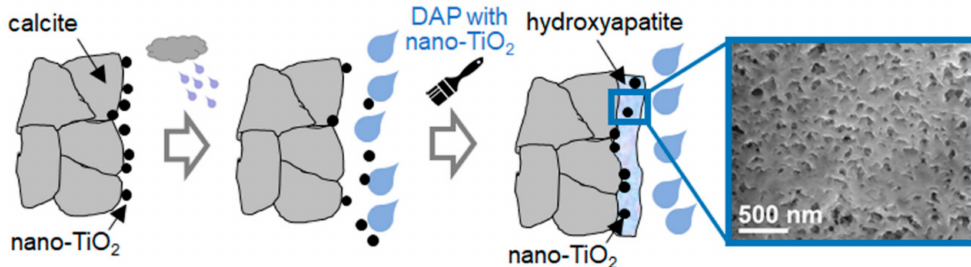
Figure 6. Scheme illustrating nanoTiO 2 removal by rain when nanoparticles are directly applied onto marble surface. A significant improvement in durability can be obtained by incorporating nanoTiO 2 in HAP coatings (on the right, a FIB-SEM cross section of a HAP-TiO 2 nanocomposite is